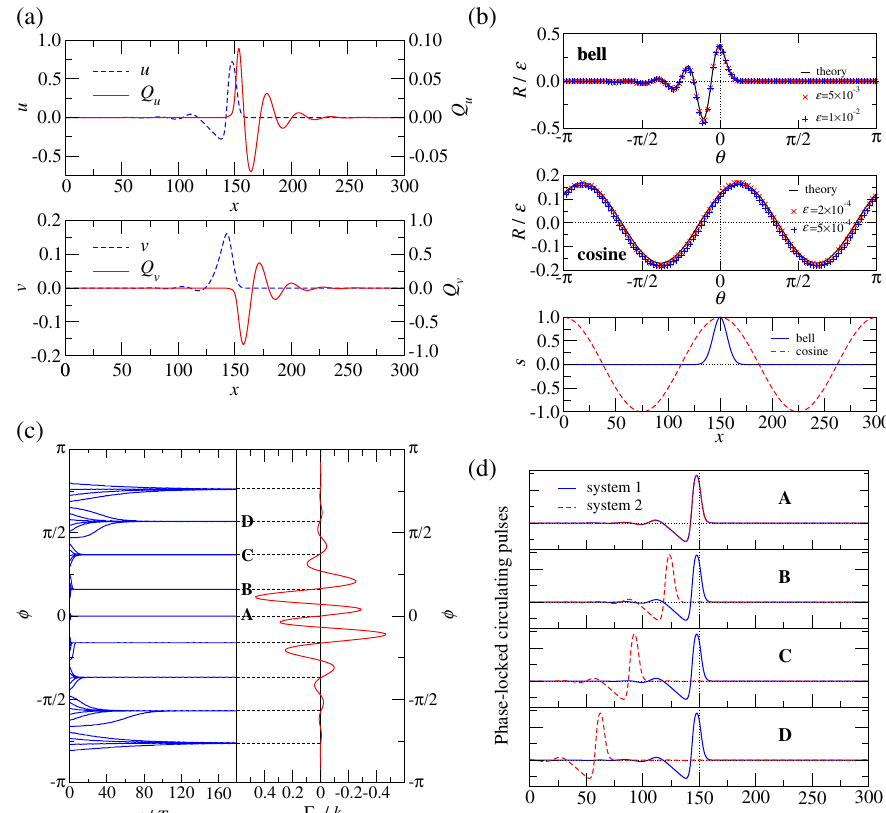
FIG. 1. Circulating pulses. The system is a 1D ring of length L ¼ 300 with periodic boundary conditions. The system parameters are α ¼ 0 , τ − 1 ¼ 0 . 018 , γ ¼ 1 , κ ¼ 1 , and δ ¼ 0 . 02 . With these values, the pulse exhibits a wavy tail [19]. The oscillation period (time needed for the pulse to go around the ring) is T ≈ 551 . 8 . (a) Snapshots of the stable circulating pulse with a wavy tail, X x ; θ Þ ¼ ½ u ð x ; θ Þ ; v ð x ; θ Þ(cid:1) , and the corresponding phase-sensitivity function, Q ð x ; θ Þ ¼ ½ Q 0 ð Phase-response curves R ð θ Þ of the circulating pulse normalized by the stimulus intensity ε . Either bell-shaped [ s ð x Þ ¼ ε exp f − ð x − 150 Þ 2 = 90 g ] or cosine [ s ð x Þ ¼ ε cos ð 4 π x= 300 Þ ] perturbation is given to the activator ( u ) component. Results obtained by direct numerical simulations with two different values of ε are compared with the theory, R ð θ Þ ¼ h Q ð x ; θ Þ ; s ð x Þi , where the inner product is taken over the 1D ring ( 0 ≤ x ≤ L ). (c) Evolution of the phase difference ϕ ¼ θ 1 − θ 2 between two systems coupled through the u component with the coupling intensity matrix K ¼ diag ð k; 0 Þ with k ¼ 0 . 001 and the antisymmetric part of the phase- coupling function Γ a ð ϕ Þ (rescaled by the coupling intensity k ). Different blue lines show the evolution of ϕ for different initial conditions. The two pulses show multimodal phase locking. (d) Snapshots of phase-locked pulses with four different stable phase differences. Graphs (A – D) correspond to the stable phase differences shown in